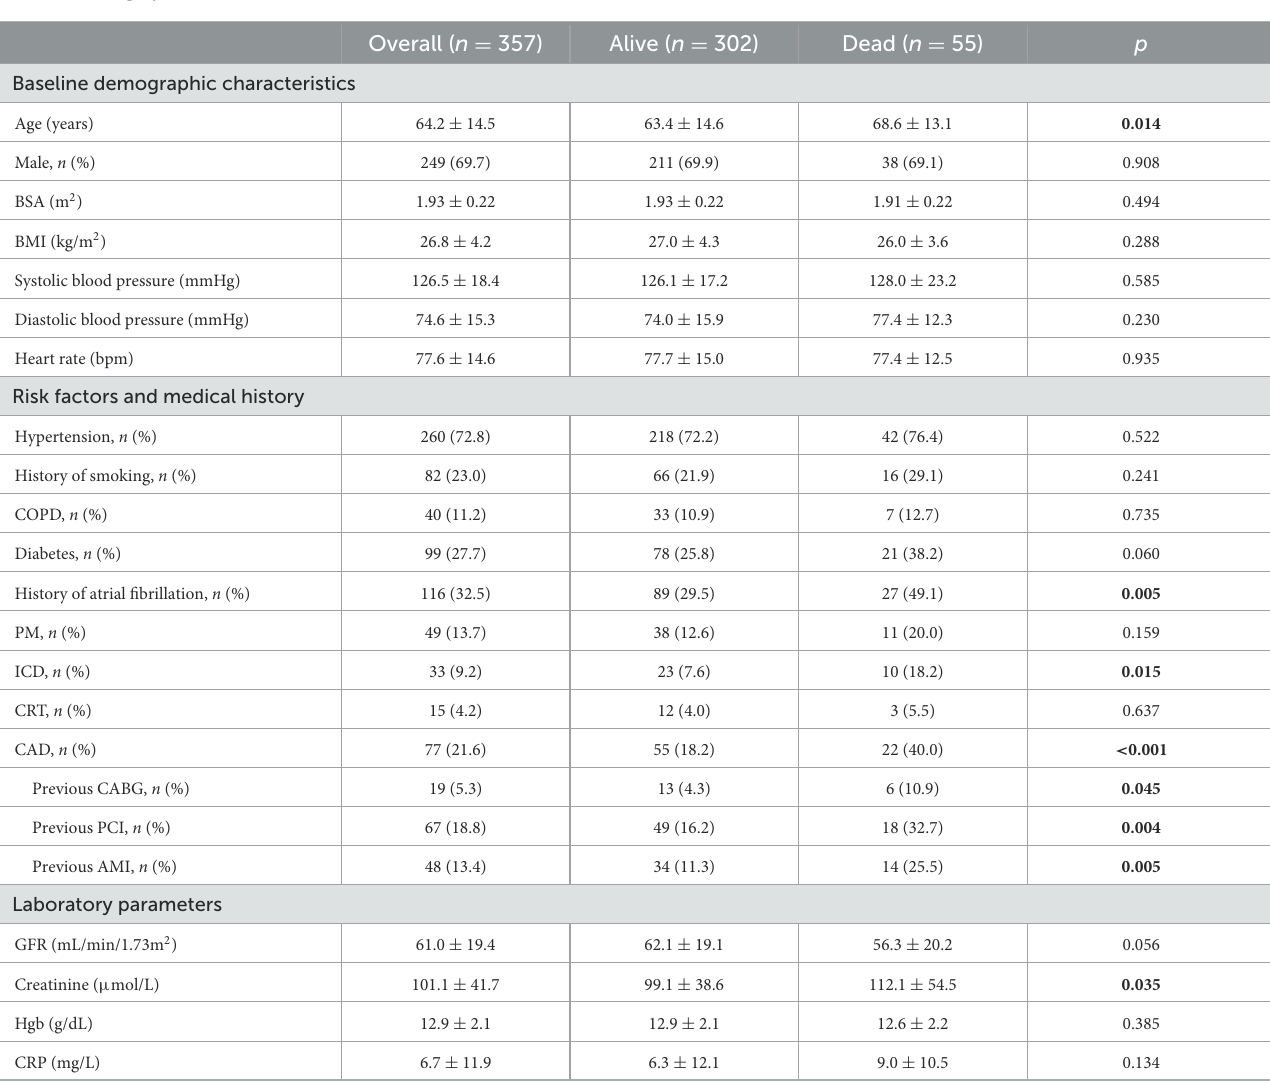
TABLE 1 Demographic and clinical